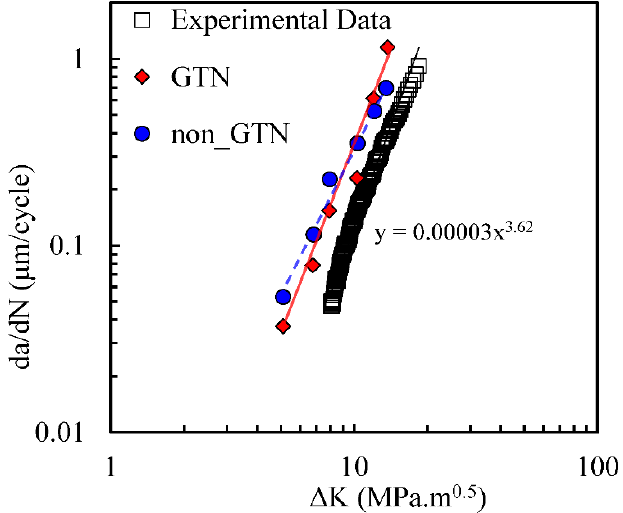
Figure 13. da/dN - Δ K curves in log-log scale (plane strain; F min = 4.17 N; F max = 41.7 N; R = 0.1). The Paris–Erdogan law parameters are shown on the equation related to the trend-line added to the experimental results.